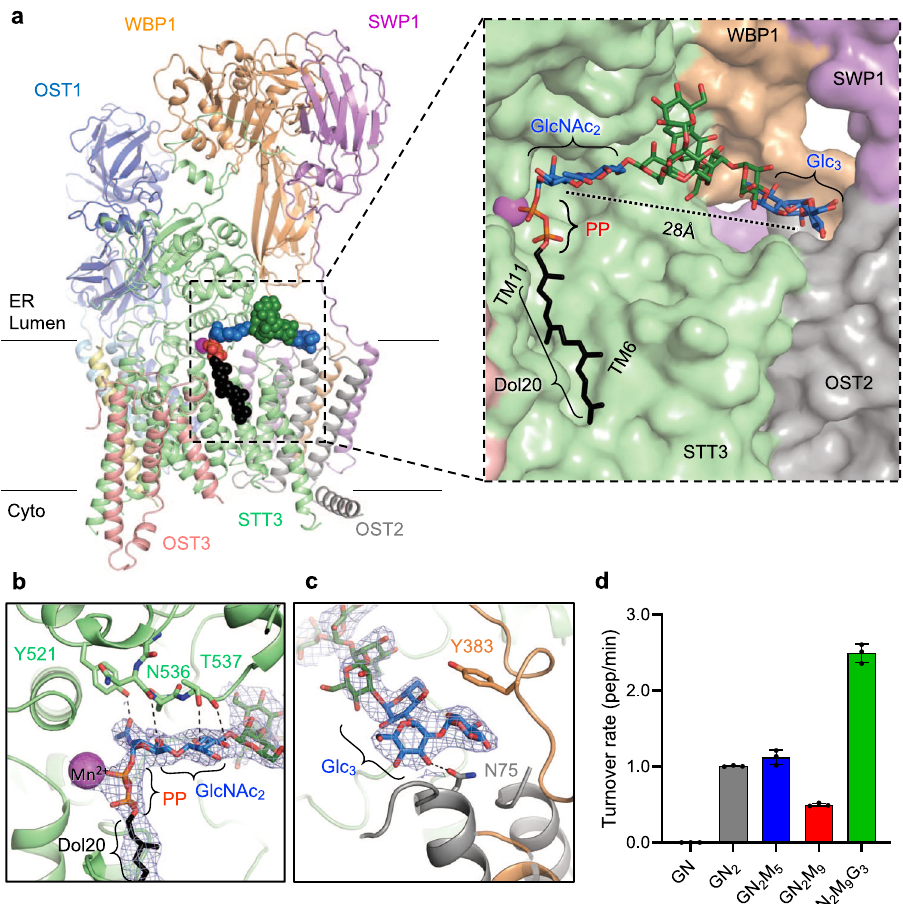
Fig. 2 | Structure of S. cerevisiae OST withbound LLOanalog. a OST structureis shown in cartoon representation. Subunits are colored individually and labeled. Bound Dol20-PP-GlcNAc 2 Man 9 Glc 3 isshown as spheres, with carbons of the Dol20 coloredblackandthoseoftheglucoseand N -acetylglucosamineunitscoloredblue andofthemannoseunitscoloredgreen.Theinsetshowsaclose-upviewoftheLLO binding site, with OST shown as surface and subunits colored as in the ribbon diagram and labeled. Dashed line indicates the distance between the recognition sitesofGlcNAc 2 andofGlc 3 . b Close-upviewoftheinteractionsoftheSTT3subunit